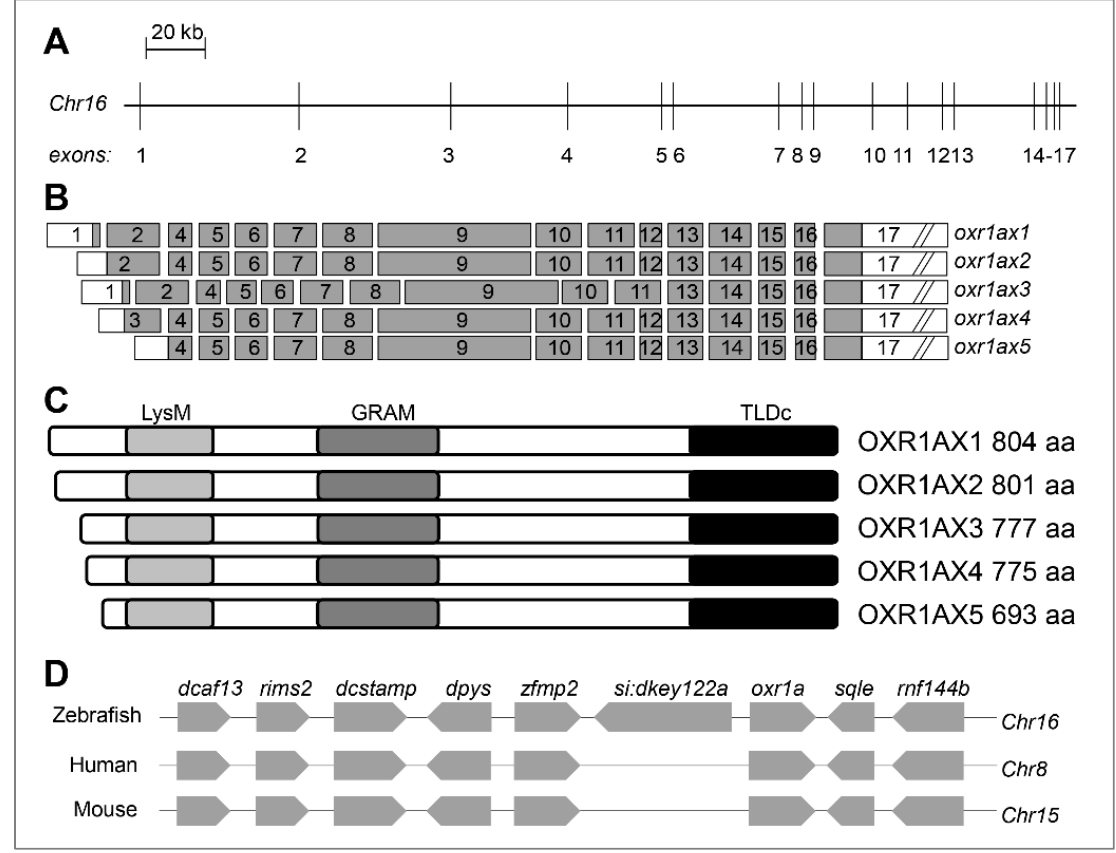
Figure 1. Genomic organization of zebrafish oxr1a gene and its synteny analysis. ( A ) Genomic structure of zebrafish oxr1a gene. The gene is located on Chr16 and consists of 17 exons with a span 324,686 bp. The intron length between exons is annotated using a scale. ( B ) Exon composition of oxr1a isoforms. The white box indicates an untranslated region and the gray box indicates open reading frame. ( C ) Predicted peptides and conserved domains of oxr1a isoforms. All isoforms contain the LysM, GRAM and TLDc domains. The predicted number of amino acids (aa) for each isoform is indicated. ( D ) Synteny analysis: seven adjacent genes ( dcaf13, rims2, dcstamp, dpys, zfmp2, sqle and rnf144b ) of zebrafish oxr1a gene are in a syntenic relationship with the human and mouse genome oxidation resistance 1 ( OXR1 ) gene.